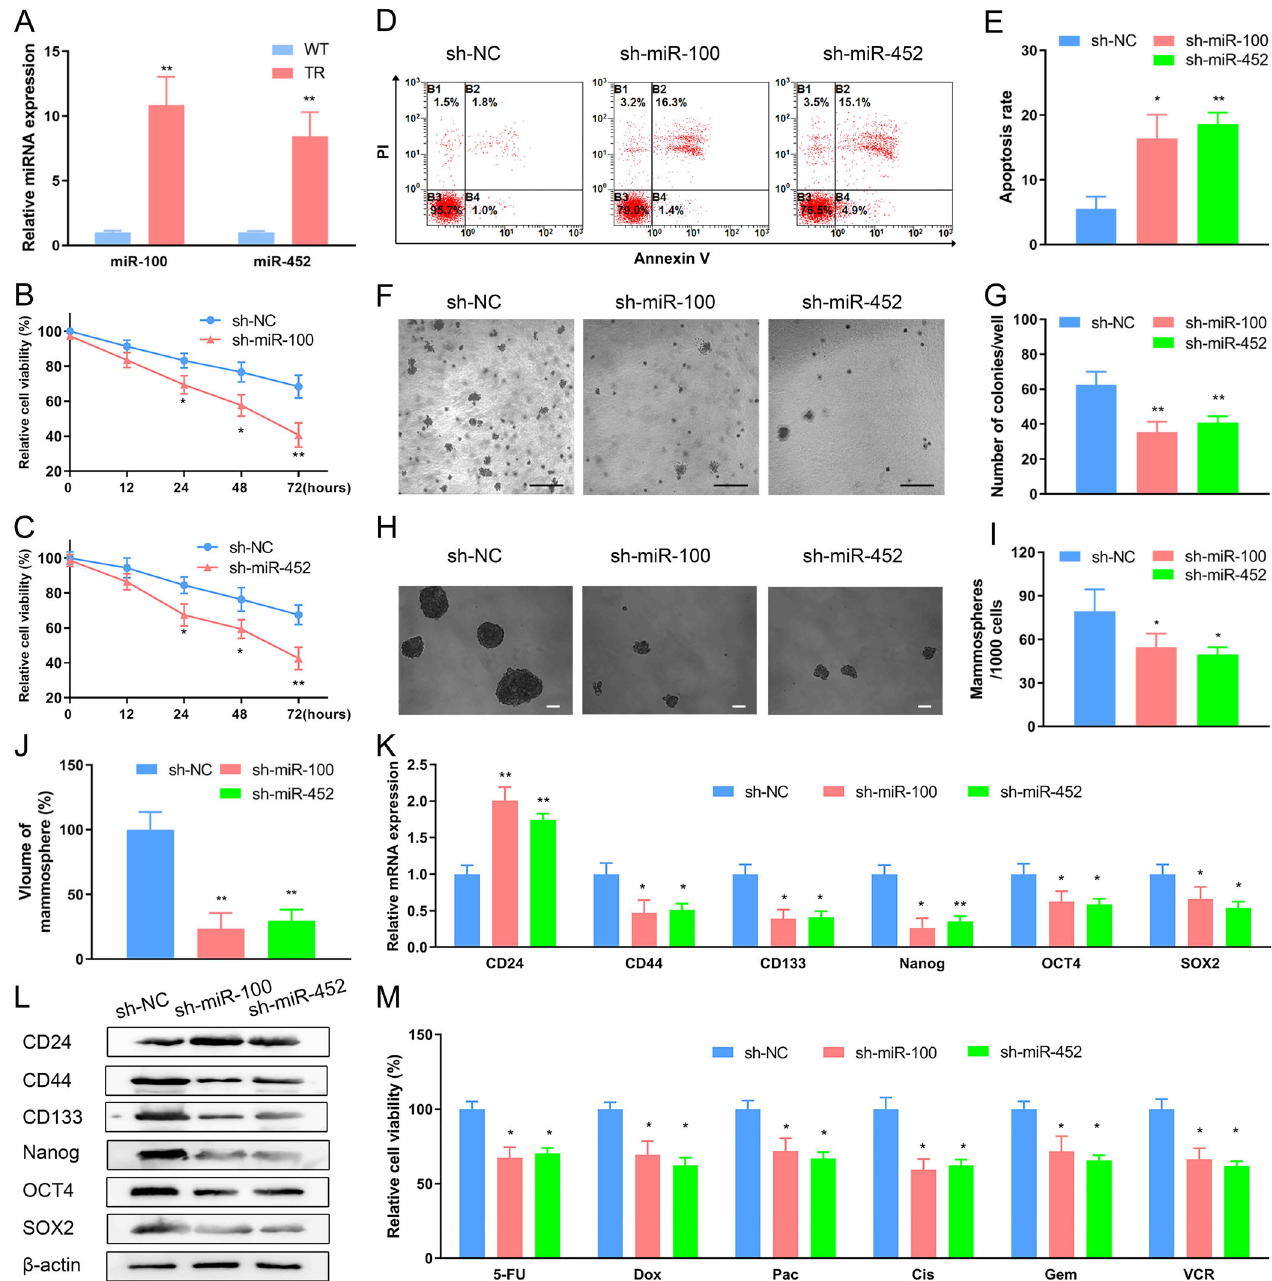
Fig. 5 Knockdown of miR-100 and miR-452 diminishes trastuzumab resistance, CSC-like properties, and multiple chemoresistance. A Expression of miR-100 and miR-452 in WT and TR cells were quanti fi ed by qRT-PCR assay and then compared. B – E TR cells were transfected with sh- miR-100 and sh- miR-452 and cultured under trastuzumab treatment for 48 h. The cell viability was evaluated using CCK-8 assay ( B , C ). The apoptosis was estimated by fl ow cytometry assay ( D ) and the apoptosis rate was calculated ( E ). F , G TR cells infected with sh-NC, sh- miR- 100, and sh- miR-452 were subjected to soft agar colony formation assay for 21 days. Represent images ( F ) and quanti fi cation of the clones ( G ) are shown. Scale bar 100 μ m. H – J MiR-100 - and miR-452 -de fi cient TR cells exhibited decreased mammosphere-formation ability in ultra-low- attachment culture environments. Represent images ( H ), quanti fi cation of clones ( I ) and volumes ( J ) are displayed. Scale bar 100 μ m. Data are shown as the mean ± SD of fi ve random high-power fi elds (HPF). K , L Expression of molecular CSC markers in breast cancer were determined by qRT-PCR ( K ) and western blotting assay ( L ), respectively. M MiR-100 -, miR-452 -, and the NC-de fi cient TR cells were exposed to 5-FU, Dox, Pac, Cis, Gem, or VCR for 48 h, followed by CCK-8 assay. Data are shown as mean ± SD; Two-way ANOVA were used to analyze the data in ( B , C )